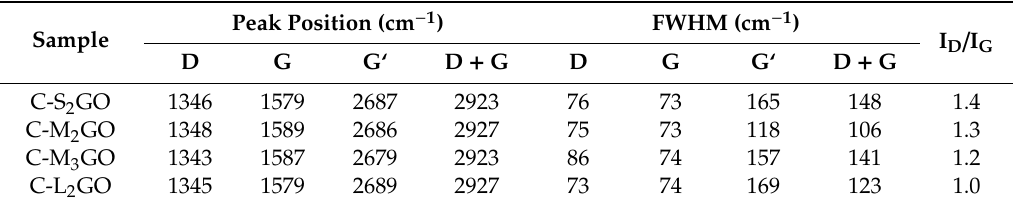
Figure 8. Collection of chosen Raman spectra of analyzed powders of graphene oxide treated with hydrazine cross-linking, according to the labeling in Table 1. Table 8. Collection of chosen parameters of Raman analysis of graphene oxide powders treated with hydrazine cross-linking, according to the labeling in Table